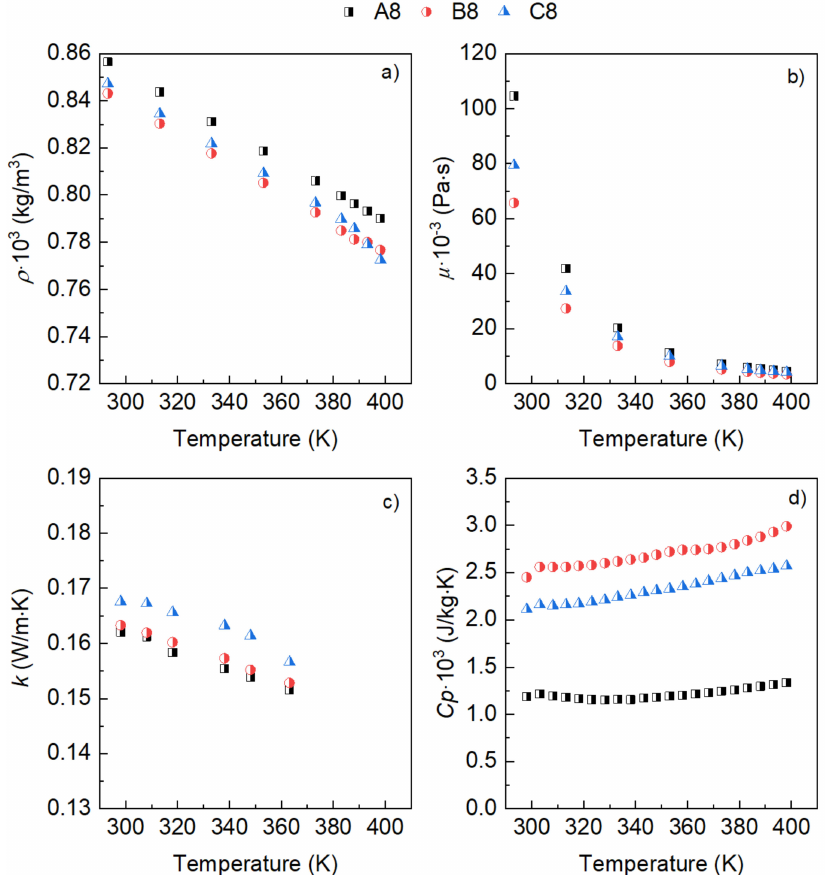
Figure 5. Thermophysical properties of the aged ATFs (A8, B8, C8): ( a ) density ( ρ ), ( b ) dynamic viscosity ( µ ), ( c ) thermal conductivity ( k ), and ( d ) heat capacity ( C p